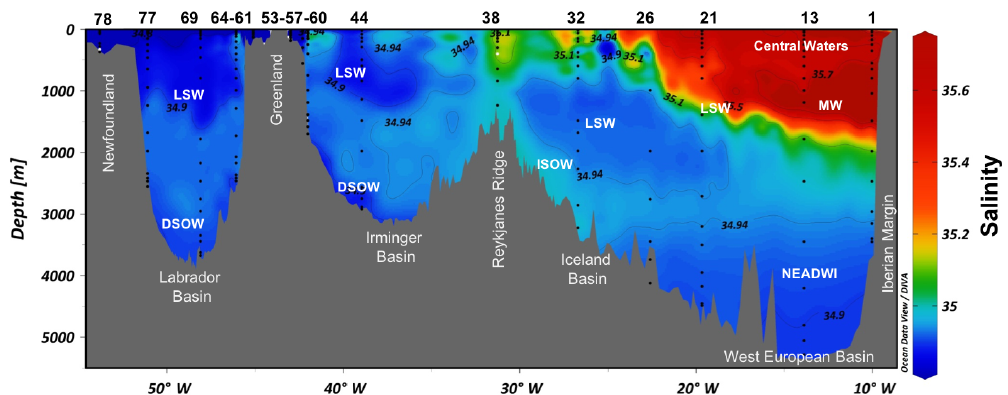
Figure 3. Distribution of salinity (CTD data) along the GA01 section. The different water masses are also reported, following García-Ibáñez et al. (2018). The station numbers are found above the figure. The sampling depths for 226 Ra are shown for each vertical profile (black